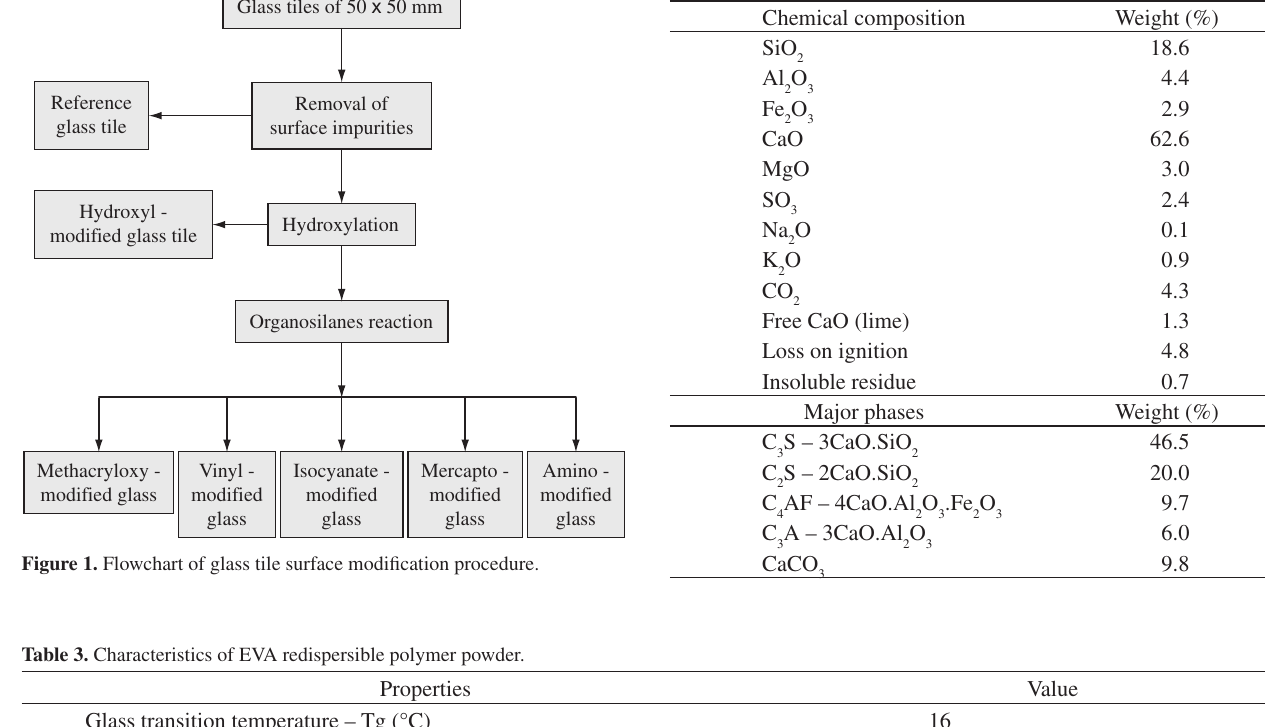
Table 2. Chemical properties of Portland cement CPII-F 32.